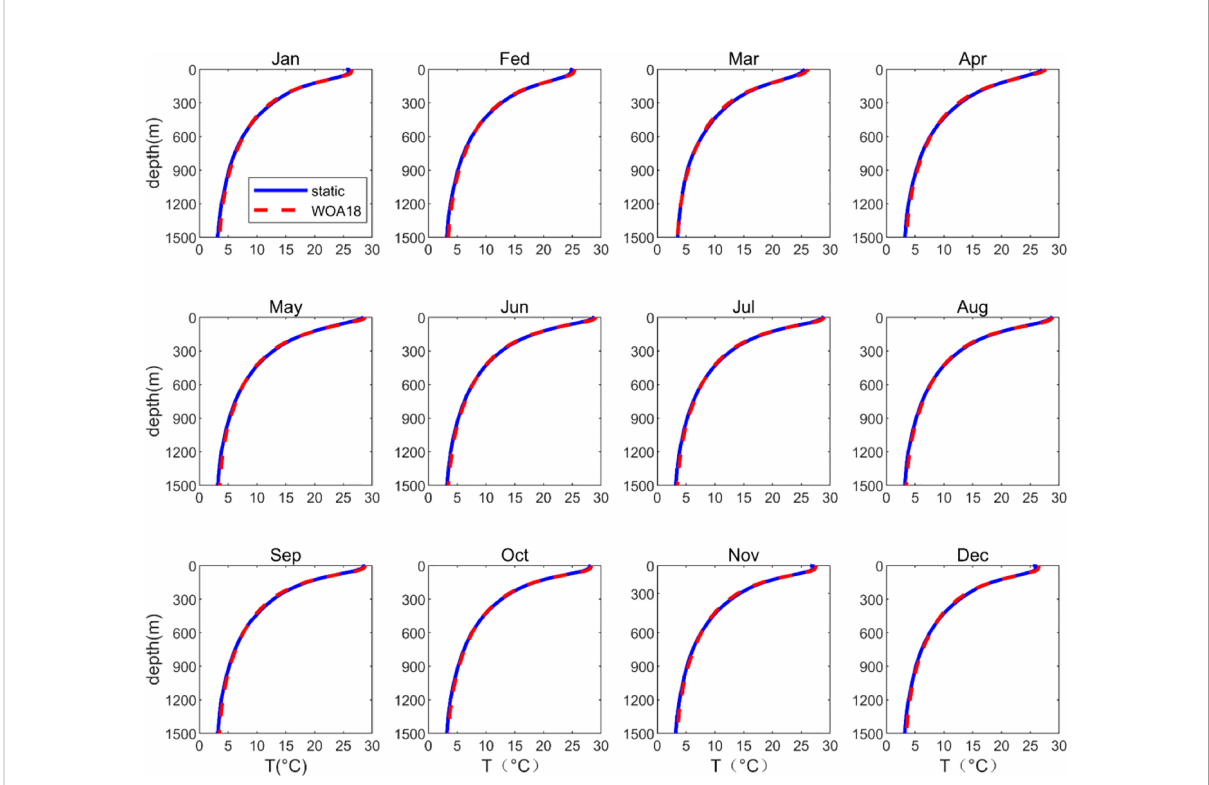
FIGURE 2 Monthly temperature pro fi les in the northern South China Sea. The blue and red lines represent the static climatic fi eld and the WOA18 data,